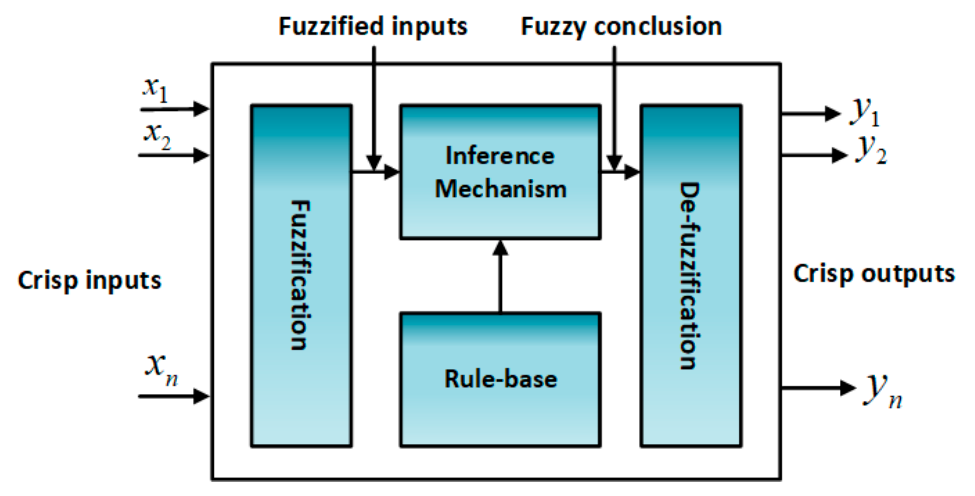
Figure 5. Fuzzy controller architecture.